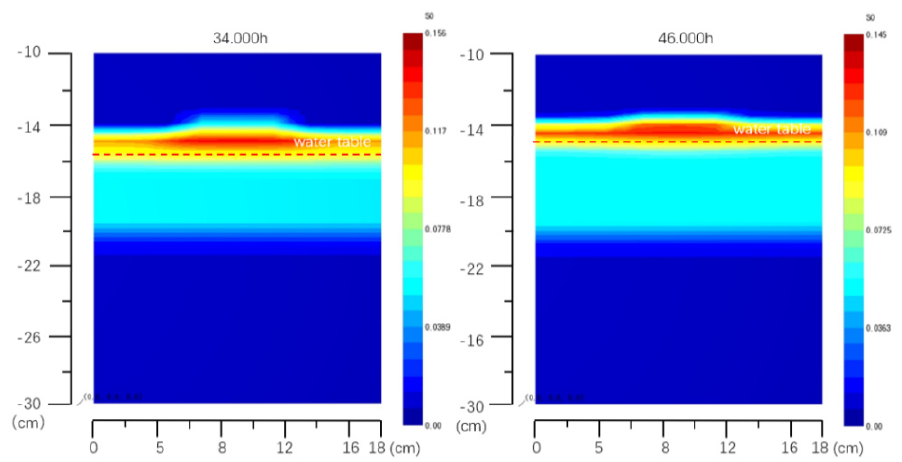
Figure 6. Redistribution of toluene in medium sand.